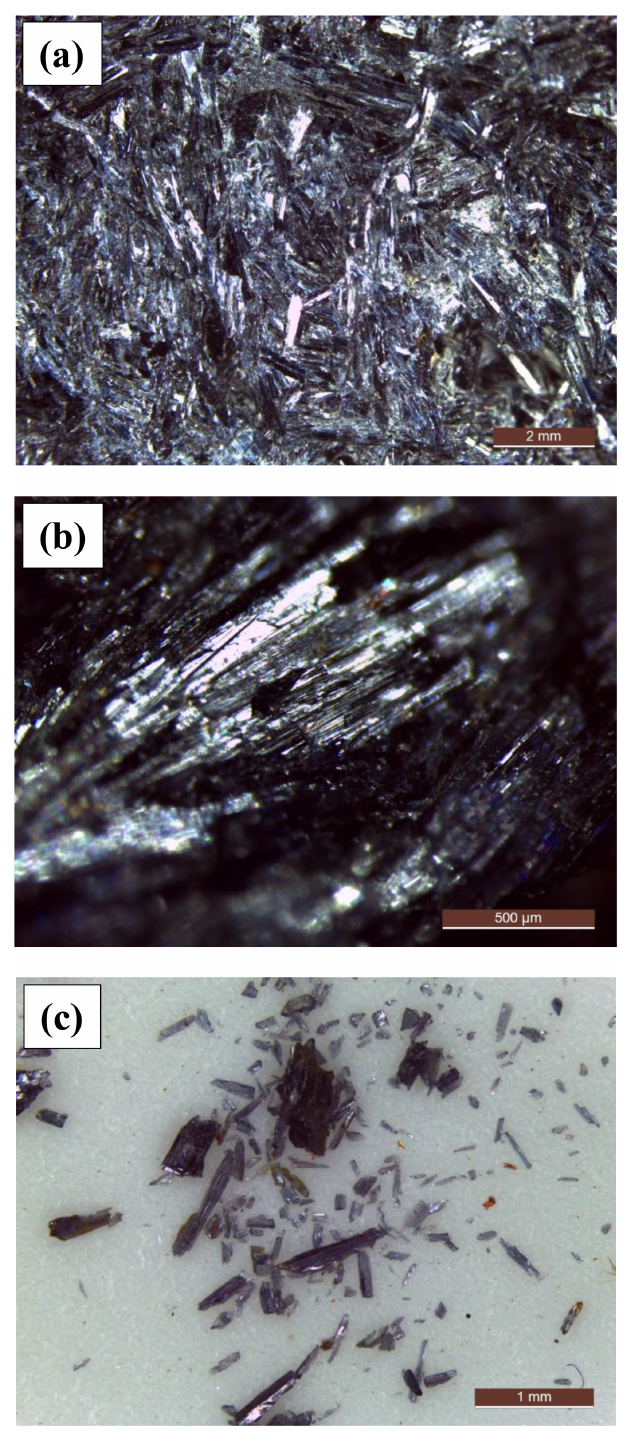
Figure 2. Optical microscopy pictures of the glaucophane sample. (a) A mix of columnar, acicular, and prismatic randomly oriented crystals; (b) parallel columnar crystals; and (c) crystals with various morphologies detached from the main rock by handling or scratch-